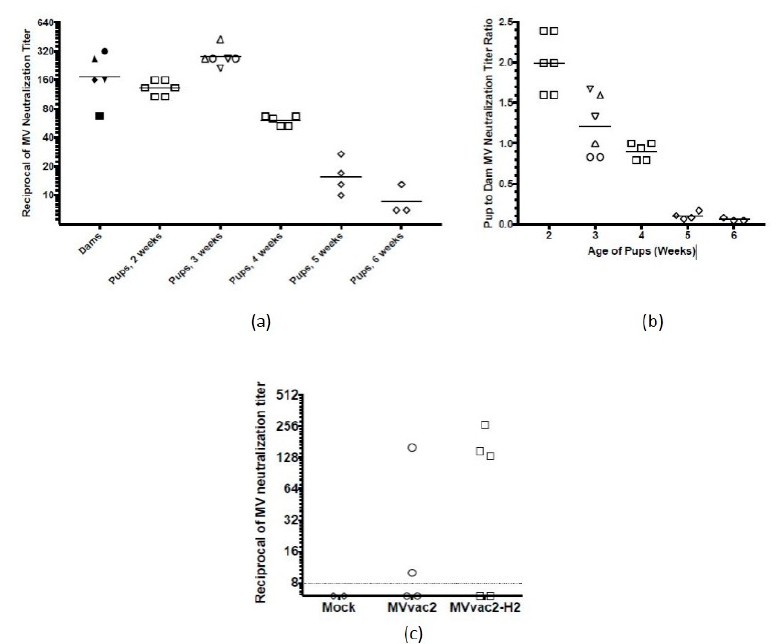
Figure 3. Natural passive transfer of anti-measles maternal immunity and vaccine immunogenicity in its presence: ( a ) time course of passive transfer of anti-MV maternal antibodies in MV-susceptible mice. Five MV-susceptible dams were vaccinated against MV and mated. Their pups were euthanized at the indicated age and serum collected to determine anti-measles status, expressed here as the raw reciprocal titers. Pups (white symbols) from the same litter share the same symbol shape, which they also share with their dam (black symbols), with each symbol representing one animal. Horizontal lines indicate group mean; ( b ) reciprocal titers from ( a ) are also expressed as ratios of pup to dam neutralizing titers; ( c ) parental and modified measles vaccine immunogenicity in the presence of maternally acquired anti-measles antibodies. Four-week-old littermates of a MV-immune dam were vaccinated with 10 5 TCID 50 of the indicated virus or mock, and anti-MV neutralizing immunity was assessed three weeks later. Each symbol represents one animal and the interrupted horizontal line indicates the limit of